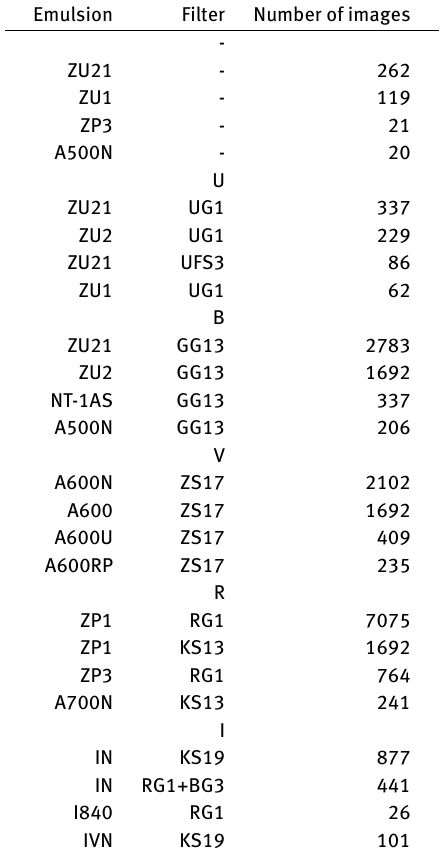
Table 1. Combinations of emulsions and filters used to provide observations in U, B, V, R, I systems.